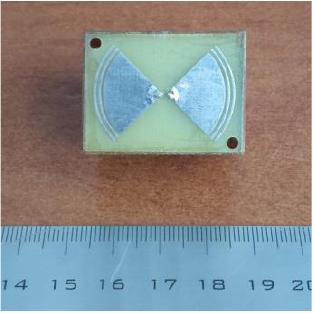
Figure 8. Bow-tie antenna.